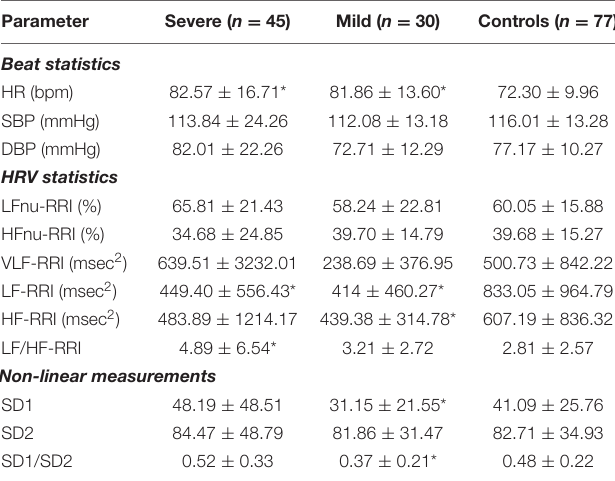
TABLE 4 | Beat-to-beat analysis of blood pressure variability and baroreceptor reflex sensitivity (Task force monitor) in COVID-19.